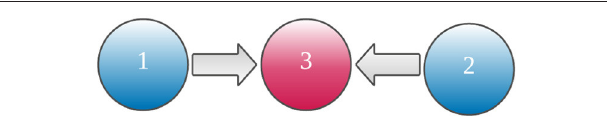
FIGURE 3 | Topology of the three-node network used to develop a dynamical logic gate (DLG).